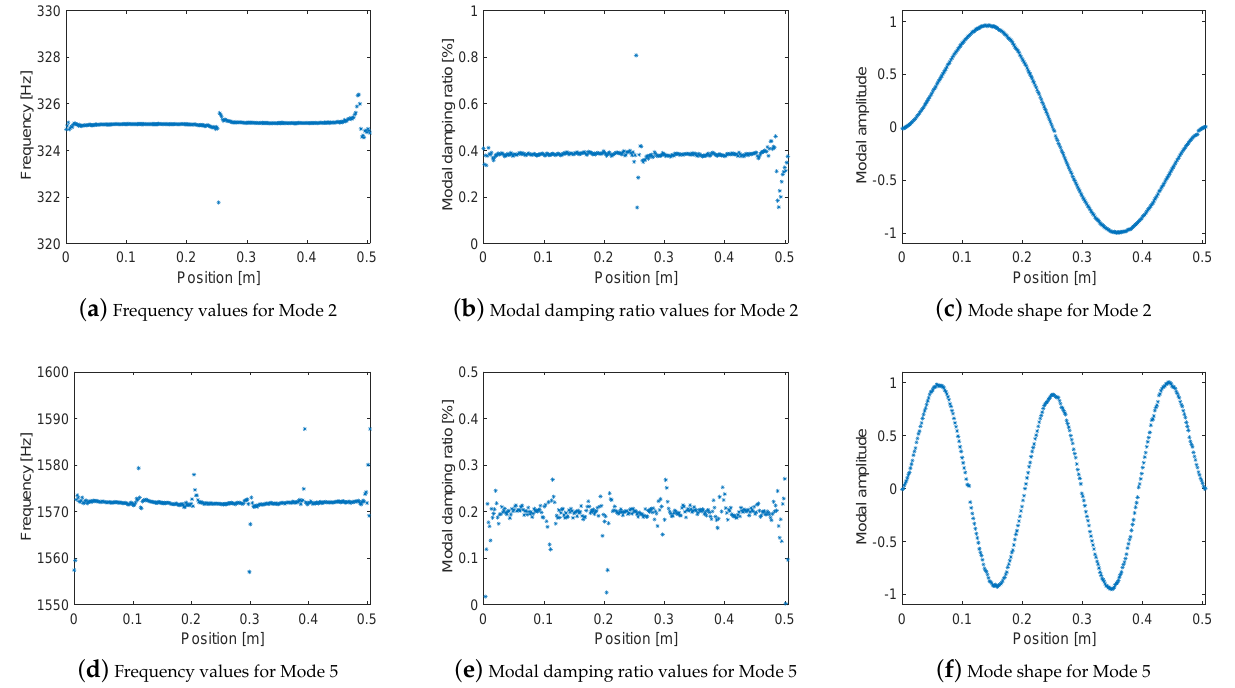
Figure 16. Modal parameters obtained from the DIC measurements for Modes 2 and 5 of the clamped–clamped